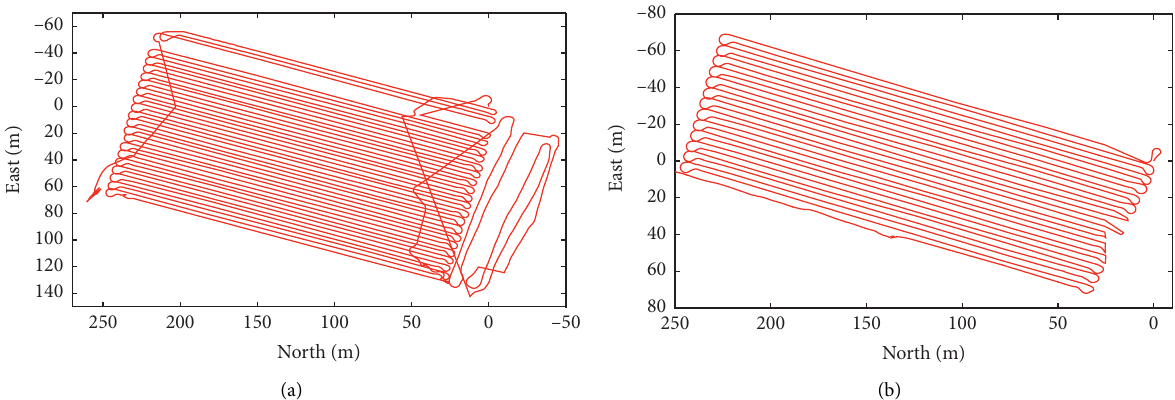
Figure 6: The path planning of USV. (a) Surface outlet stilling basin. (b) Bottom outlet stilling basin.